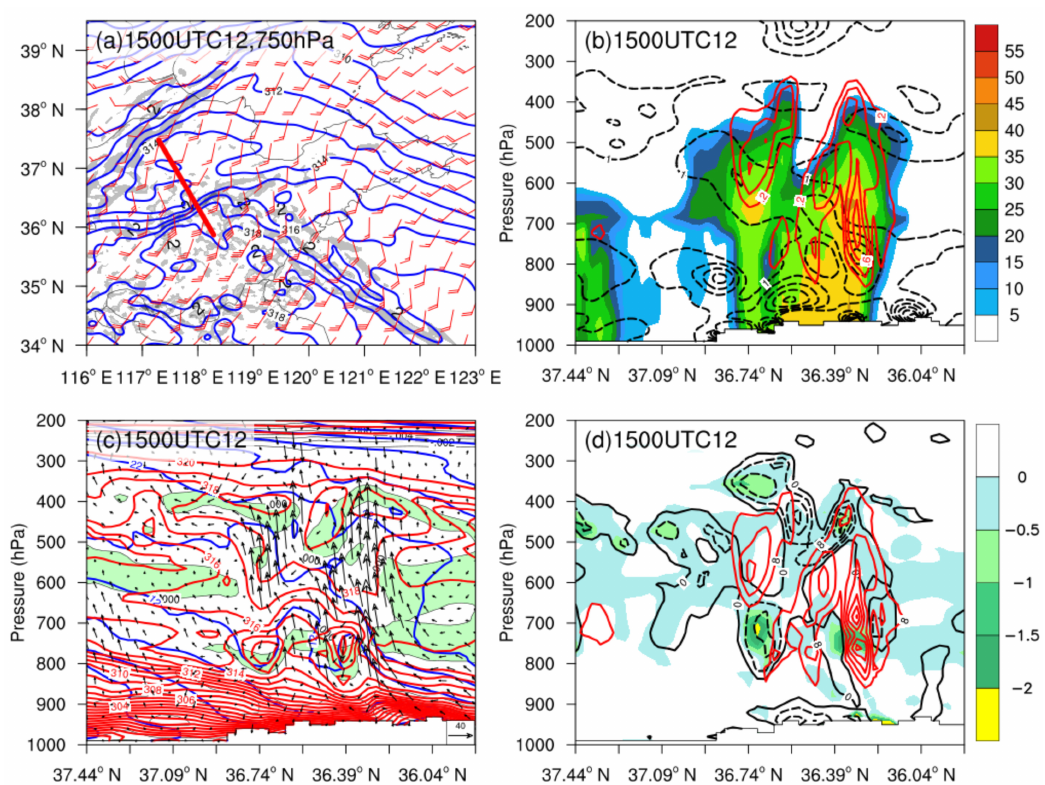
Figure 12. As in Figure 10, but for the 4 km run valid at 1500 UTC 12 February